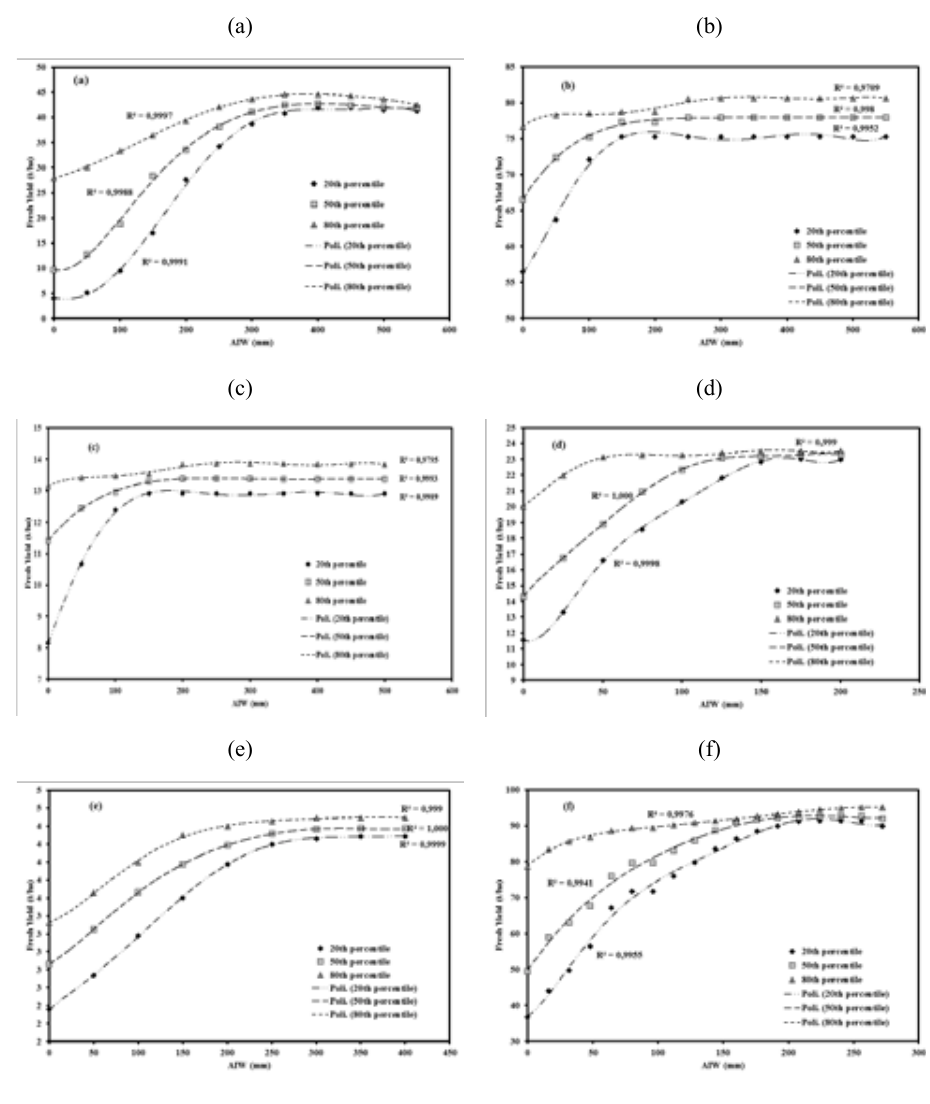
Figure 2. Simulated biomass production for 8 years in response to different levels of applied irrigation water (AIW): (a) Sugar beet; (b) Silage Maize; (c) Maize; (d) Sorghum; (e) Soybean; (f) Tomato.